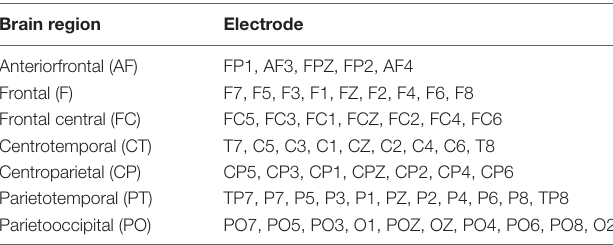
TABLE 2 | The analysis of the brain regions and the corresponding electrodes in this study. Brain